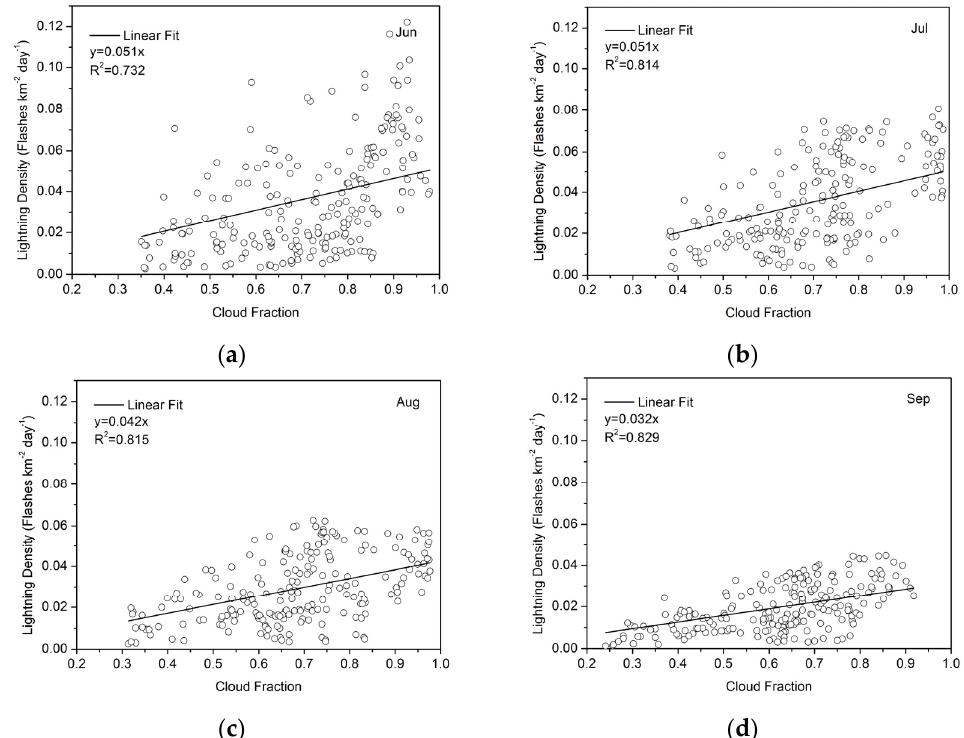
Figure 3. Correlation between lightning flash density (flashes km − 2 ·year − 1 ) and cloud fraction for June to September over China. ( a ) June; ( b ) July; ( c ) August; ( d ) September.